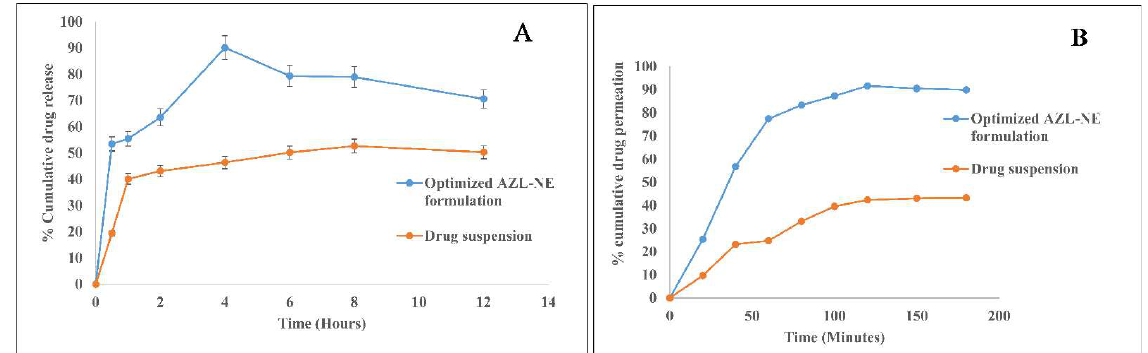
Figure 8. In vitro drug release comparison of optimized AZL-NE formulation with drug suspension ( A ) and ex vivo intestinal permeation comparison of optimized AZL-NE formulation with a drug suspension ( B ).